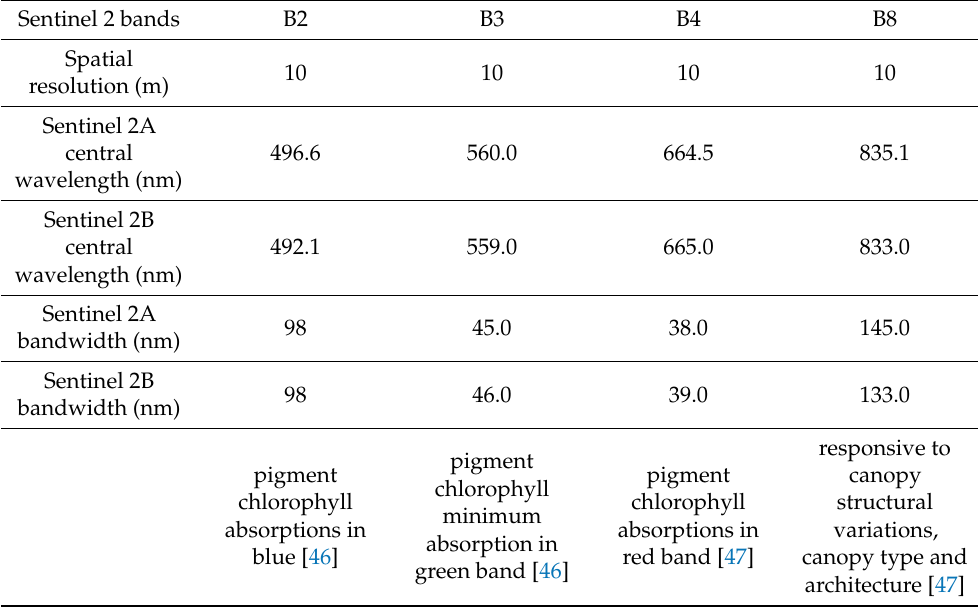
Table 1. Most frequent Sentinel 2 channels used in the calculations